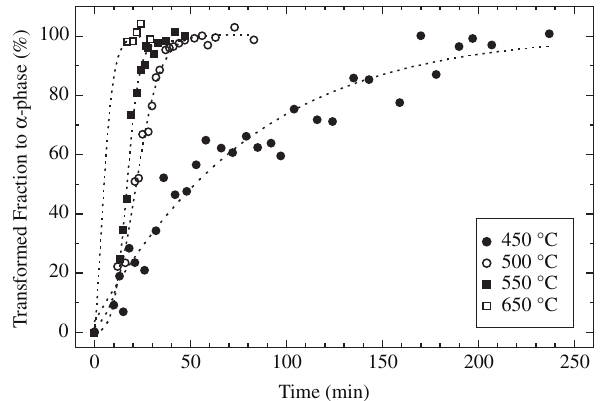
Figure 5. δ -to- α transformation kinetics for temperatures between 450 and 650